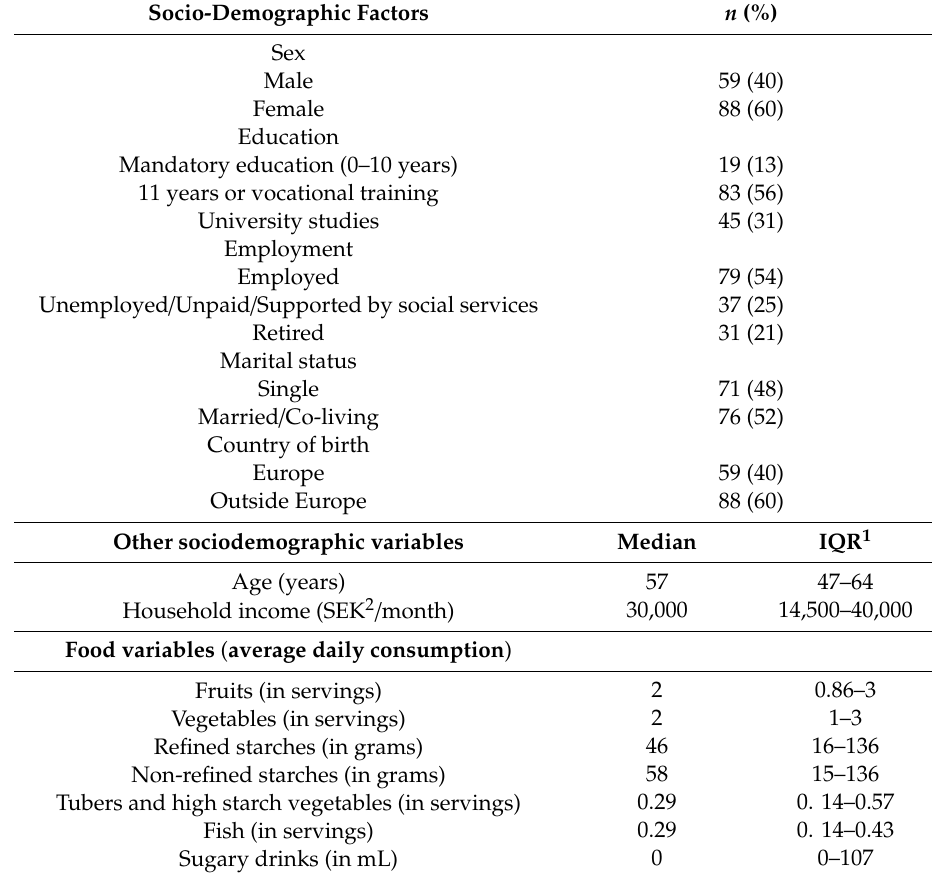
Table 2. Summary of socio-demographic factors and daily diet habits of the study participants ( n = 147).